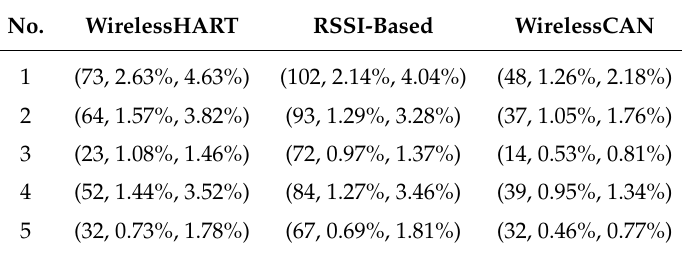
Table 2. Results of Practical